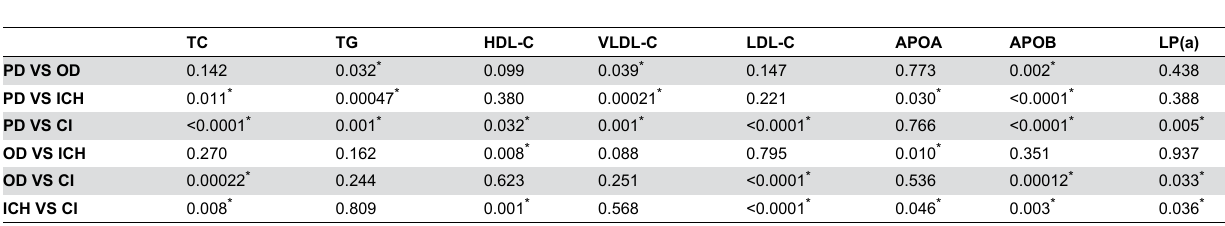
Table 4. The post-hoc comparisons of lipids and lipoproteins in the four